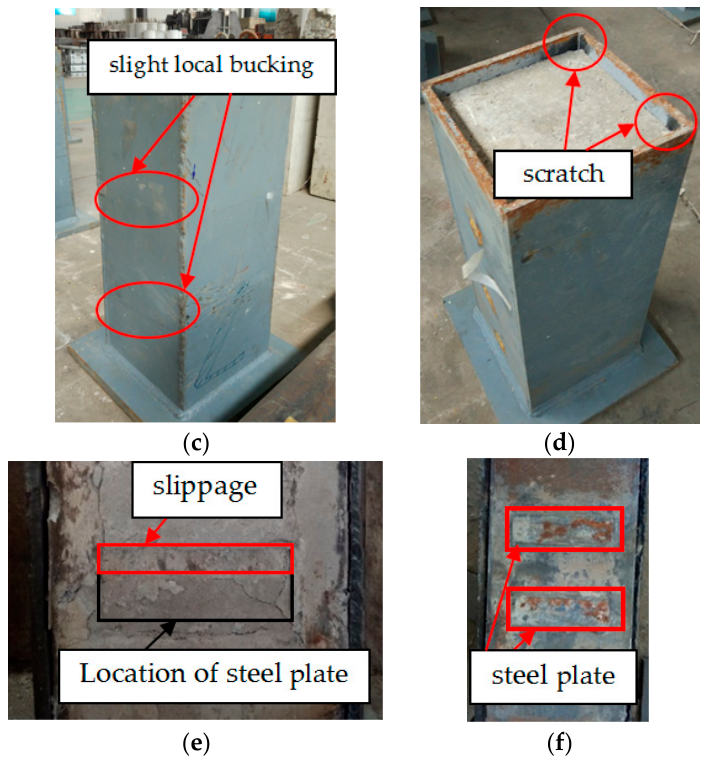
Figure 6. Failure models of specimens. ( a ) Failure Mode A; ( b ) Failure Mode B; ( c ) Slight local buckling ( d ) The scratch of inner wall; ( e ) Shear failure of core concrete; ( f ) Steel plate.